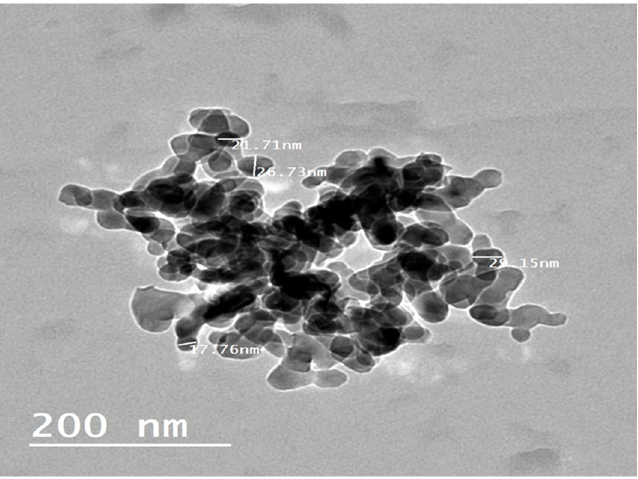
Figure 2. Transmission electron microscope image of alginate-bromocriptine nanocomposite with scale 200 nm at 25 °C.